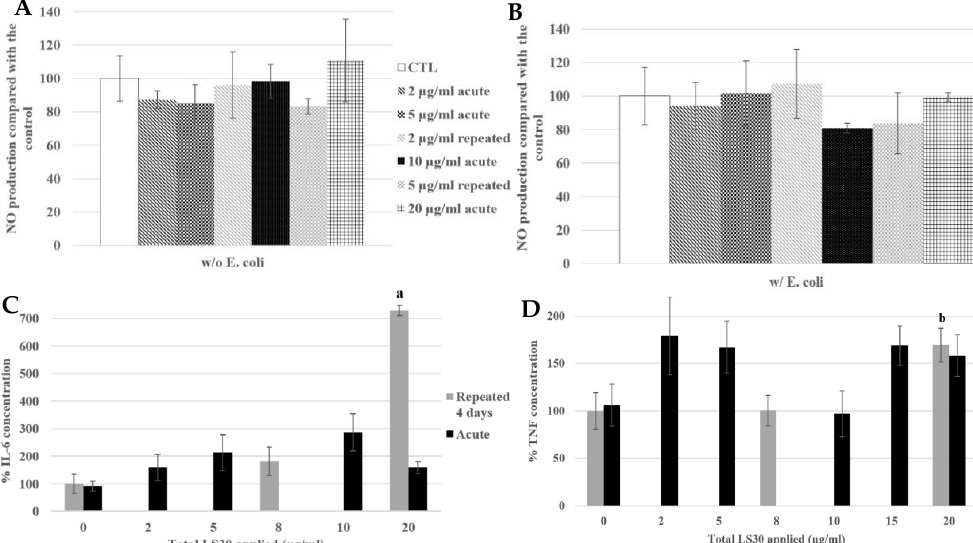
Figure 10. 4-day chronic exposure of RAW264.7 to LS30 NP and 18 h to Escherichia coli compared with silica acute exposure. ( A , B ) NO dosage with the Griess reagent by spectrophotometry without or with E. coli stimulation. ( C , D ) Cytokine release measurement of LS30 exposed cells, in absence of E. coli stimulation by flow cytometry, respectively IL-6 and TNF. (a: CTL versus repeated 5 µg/mL, p -value < 0.01; b: CTL versus repeated 5 µg/mL, p -value < 0.05).